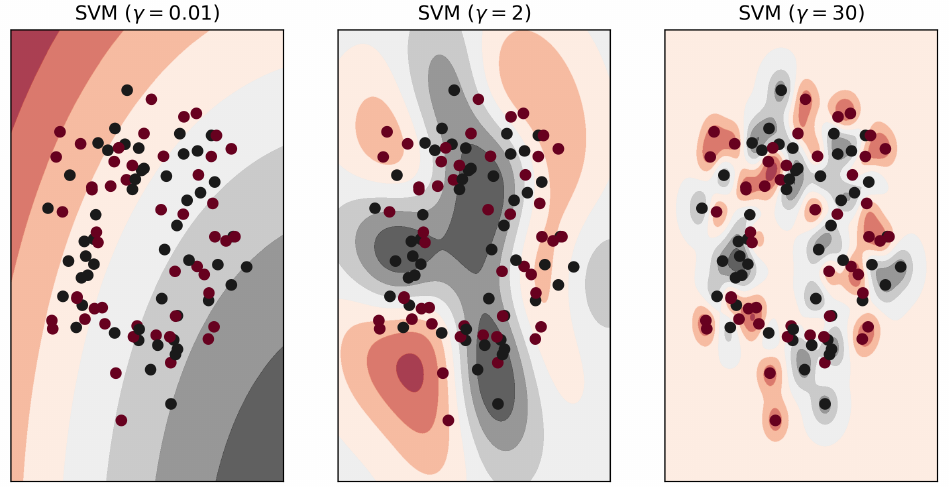
Figure 5. Kernel parameter γ for underfitting, regularized, and overfitting models